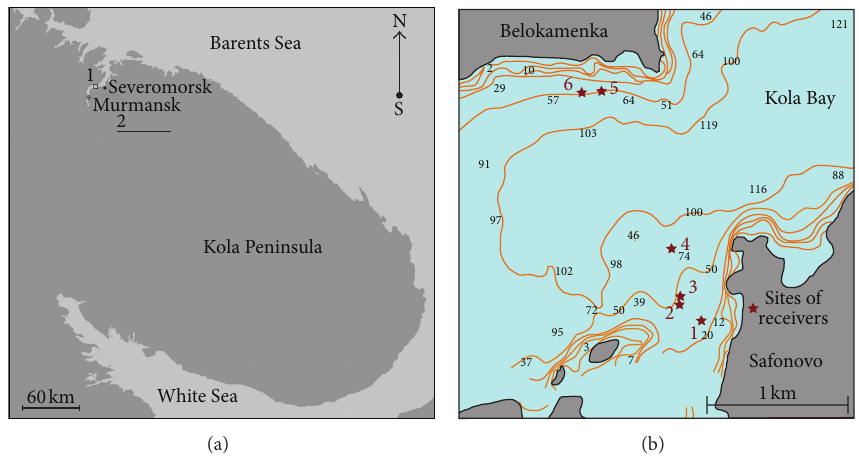
Figure 2: Region of electromagnetic sounding. (a)Area of observations, 1, and the source bipole, 2. (b) Observation sites.